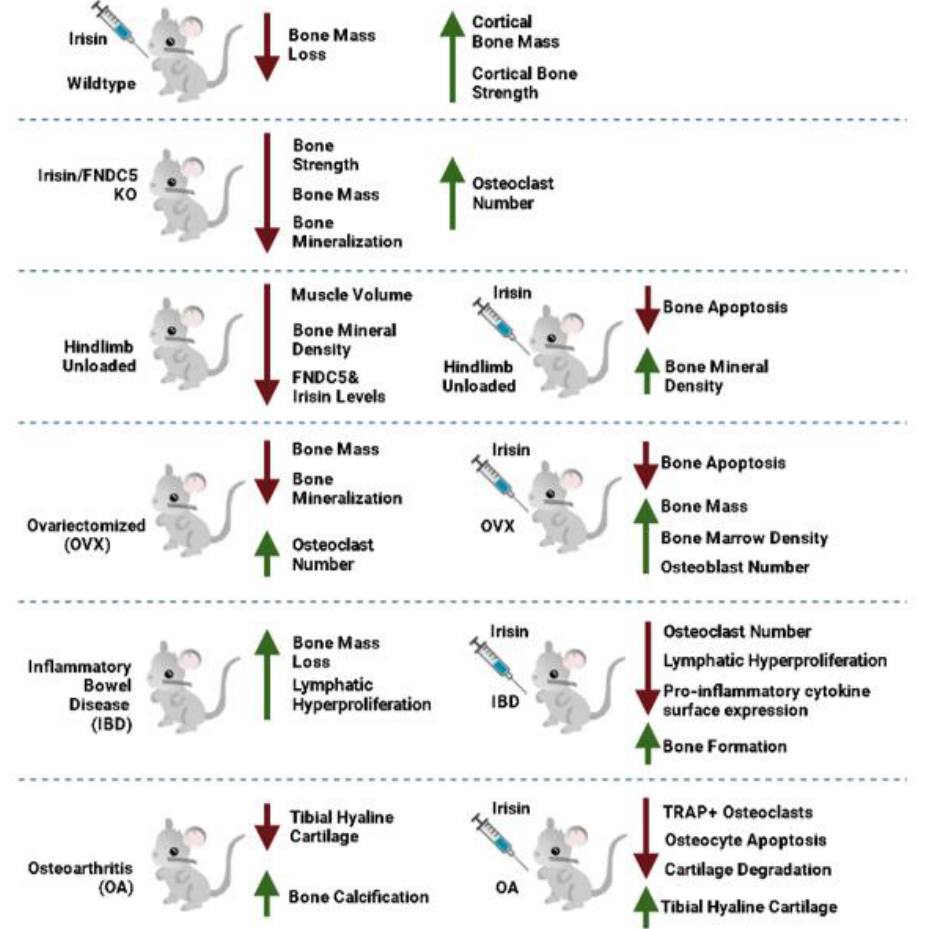
Figure 4. Effects of irisin treatment on bone homeostasis in vivo. The figure is based on the data of the studies [59,69–71,74–83] and created using BioRender. Available online: https://biorender.com (accessed on 3 February – 17 August 2021).